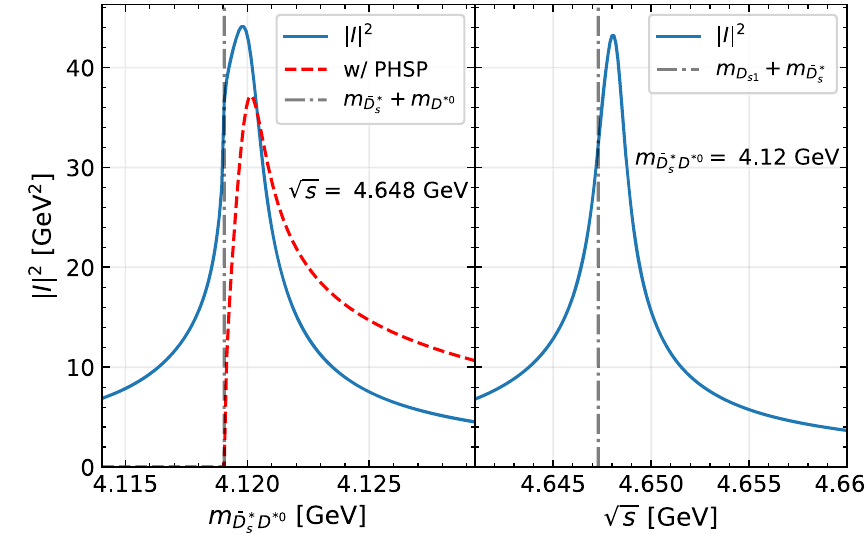
Fig. 6 Absolute squared value of the scalar triangle loop integral, | I | 2 , with the D s 1 ¯ D ∗ s D ∗ 0 triangle diagram shown as Fig. 5(a). Left: dependence on the ¯ D ∗ s D ∗ 0 invariant mass for √ s = 4 . 648 GeV, where we also show | I | 2 convoluted with the phase space, with the maximum normalized to that of √ | I | 2 ; right: dependence on s = 4 . 12 with m ¯ D ∗ s D ∗ 0